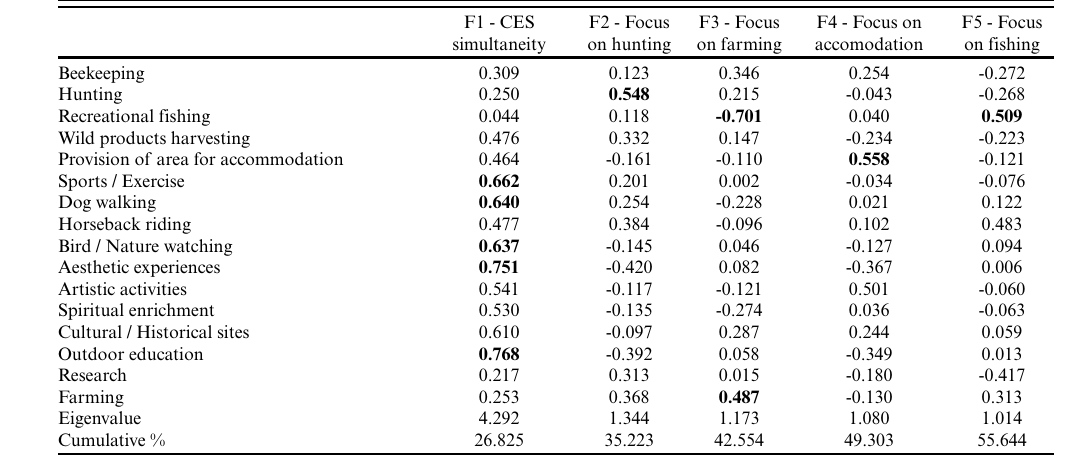
Table 2 . Factor loadings derived from the principal component analysis for current cultural ecosystem services (CES). For each variable, values in bold correspond to the factor for which the squared cosine is the largest.